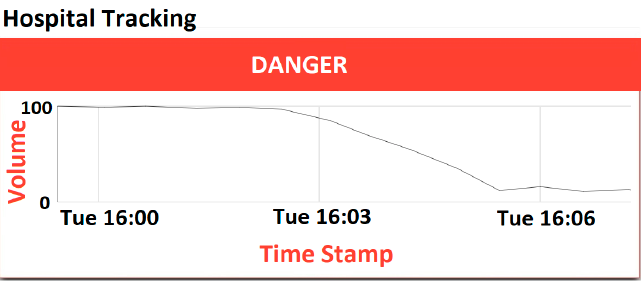
Figure 21. Danger alarm for end chamber conditions.